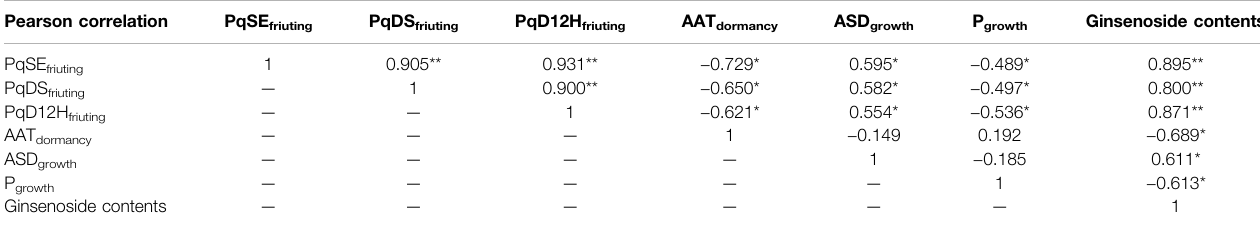
TABLE 6 | Pearson correlation analysis of the gene expression level, the key phenological factors, and the ginsenoside contents. Pearson correlation